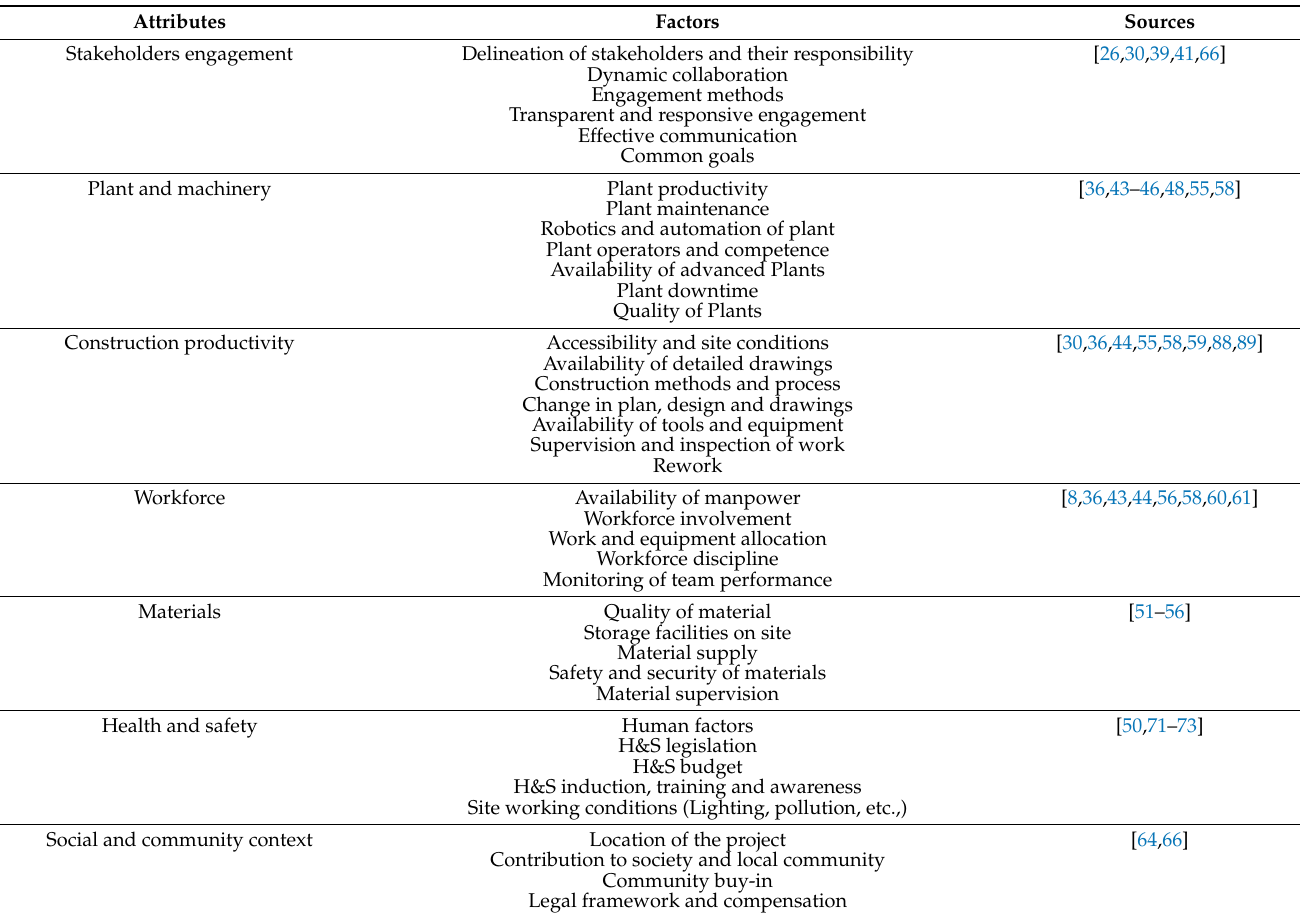
Table A1. Aspects and related factors with literature sources used in the conceptual framework to improve construction at sites of